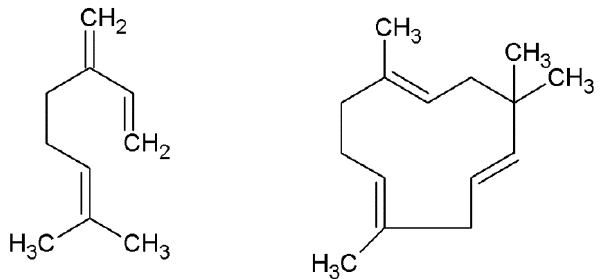
Figure 1. The chemical structures of β-myrcene and α-humulene.